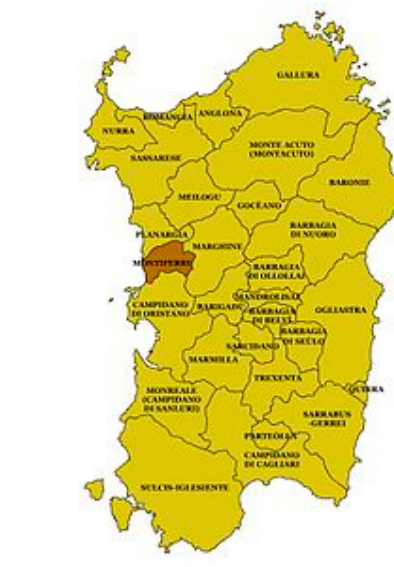
Table 1. Explanatory variables involved in the data envelopment analysis (DEA).